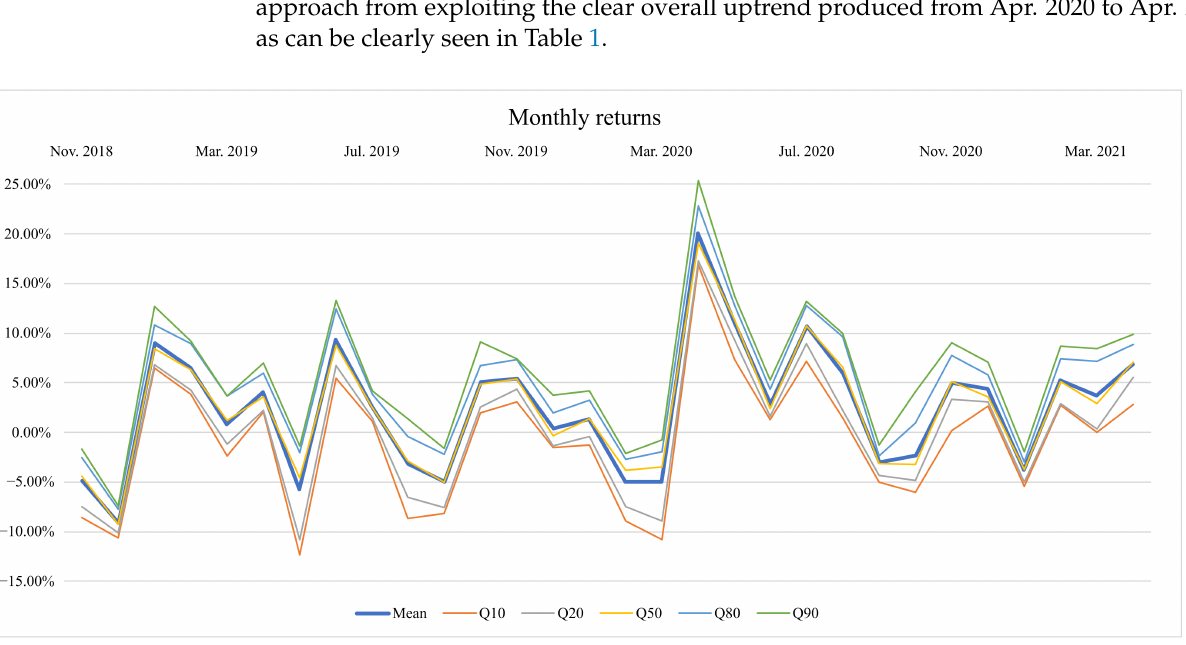
Figure 1. Monthly returns of our approach for the mean and several quantiles.